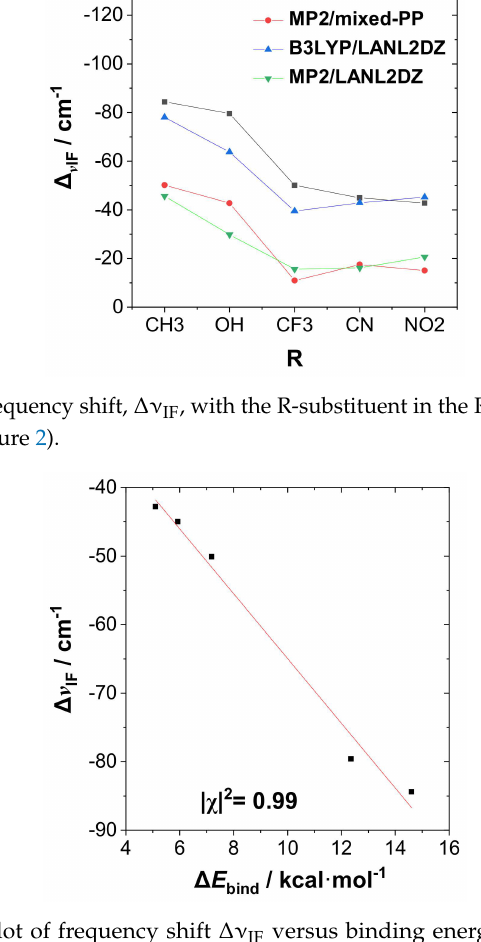
Figure 4. Correlation plot of frequency shift ∆ ν IF versus binding energy ∆ E bind for the RPH 2 ··· IF species (B3LYP / mixed-PP level), showing the excellent least-squares regression fit (dashed line) and Pearson correlation coe ffi cient ( | χ | 2 = 0.99) for these experimentally measurable